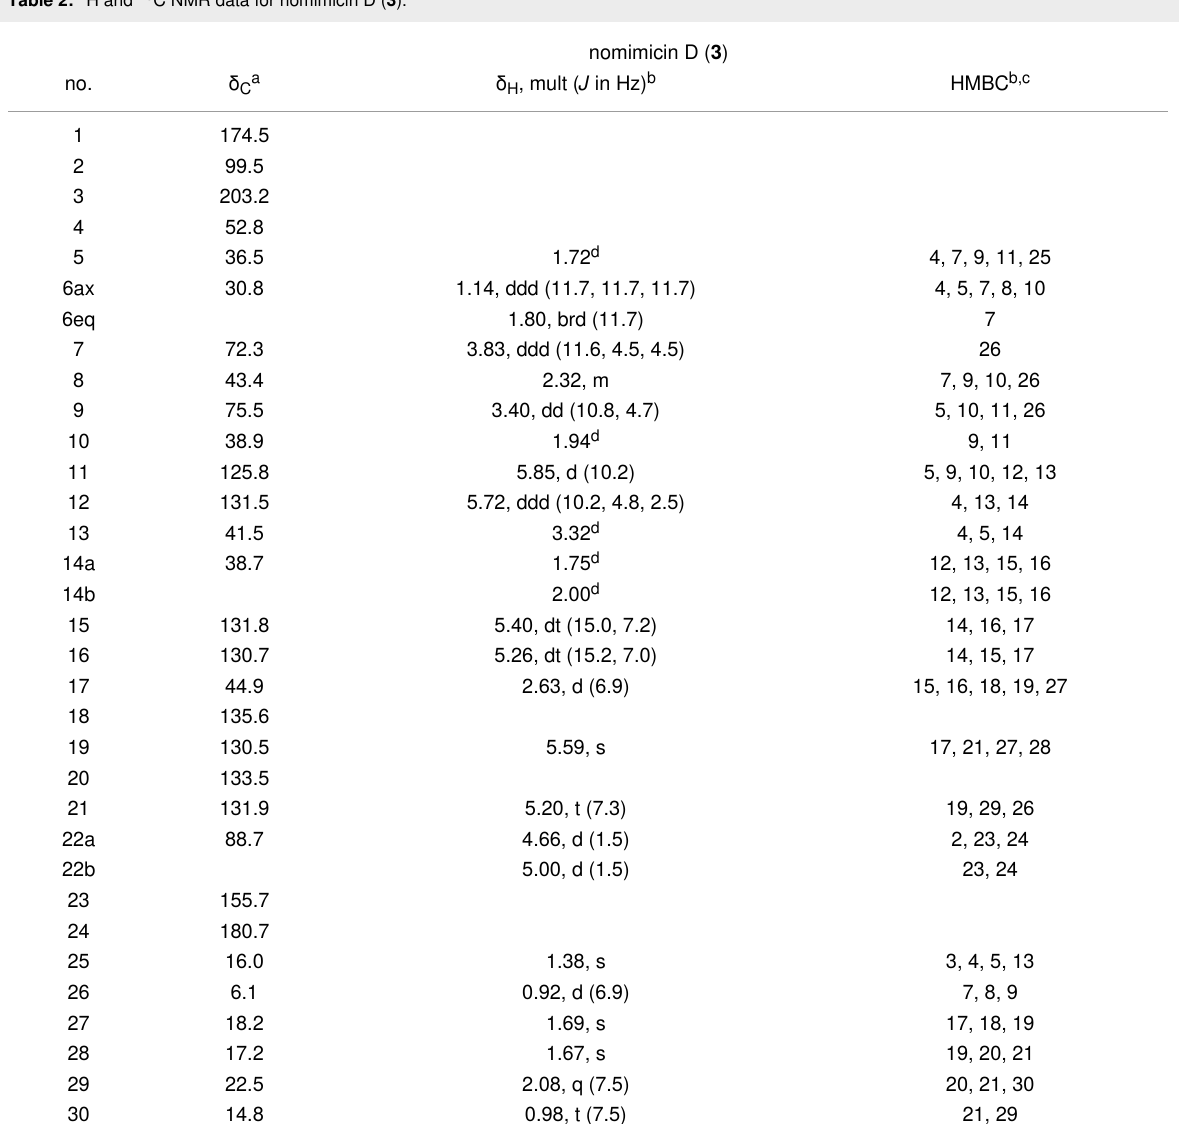
Table 2: 1 H and 13 C NMR data for nomimicin D ( 3 ).